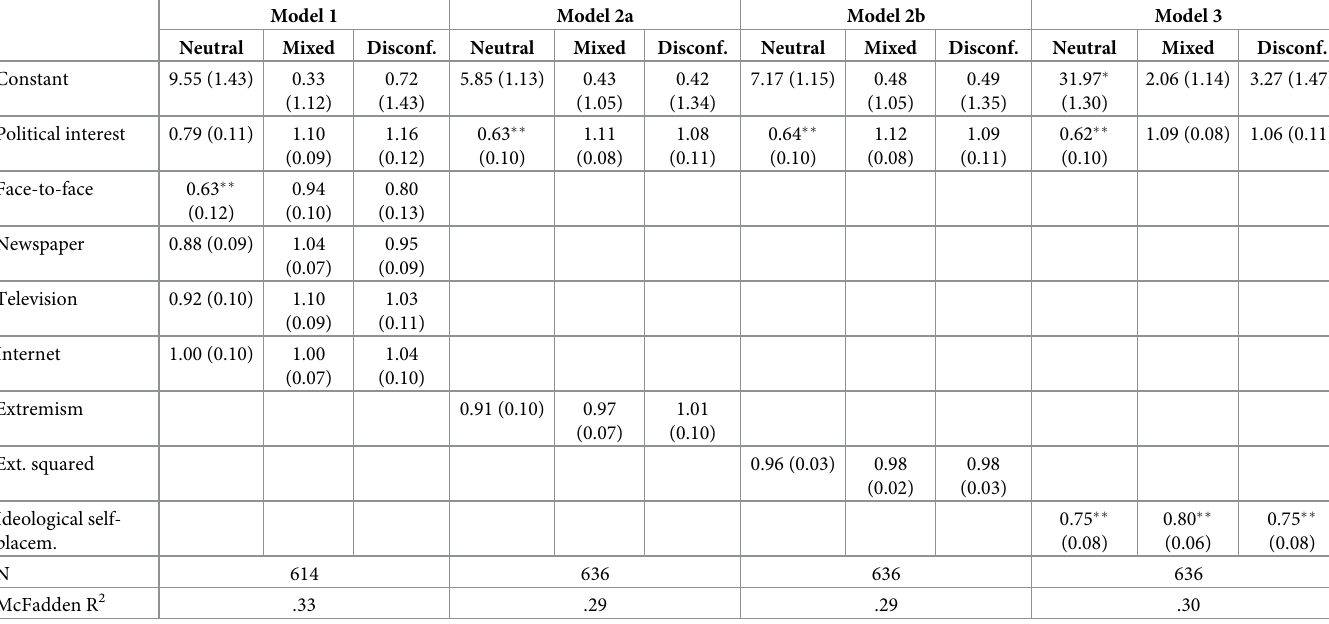
Table 4. Multinomial logistic regression analyses predicting information